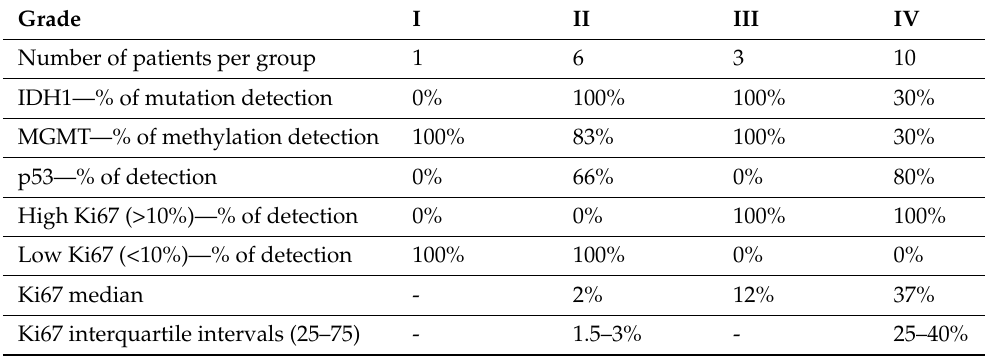
Table 1. Morphometric evaluation of tumor markers in gliomal tissue of different anaplasia grades in 20